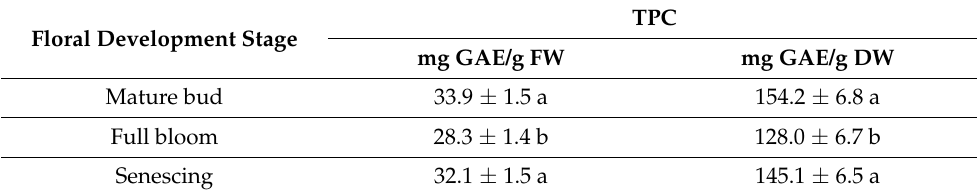
Table 2. Content of total phenolic compounds (TPC) at the three flowering stages of P. ‘Endsleigh’,